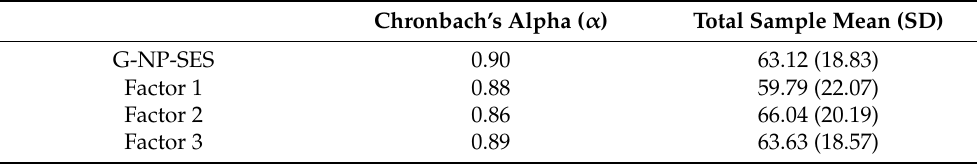
Table 5. Chronbach’s alpha ( α ) and descriptive data for the G-NP-SES and its subdimensions.